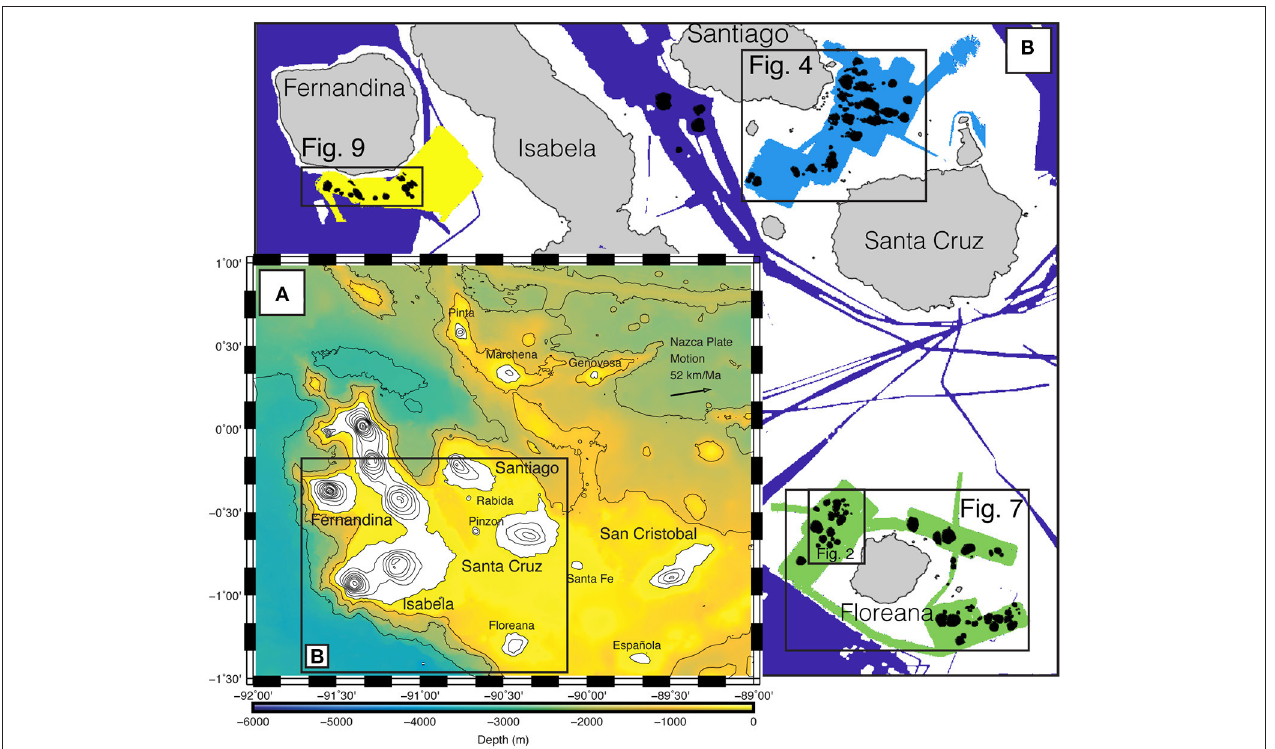
FIGURE 1 | (A) Map of the Galápagos Archipelago. Subaerial contours show elevations at 200m intervals (Weatherall et al., 2015). Submarine contours show bathymetry at 500m intervals. Solid black box indicates location of (B) in this figure. (B) Mapped regions and seamounts. Gray polygons show island locations. Dark violet polygon shows previously collected bathymetry, other colored polygons (light blue, yellow, green) show mapping locations from this study and are shown in more detail in Figures 4 , 7 , 9 . Solid black polygons show footprints of newly located